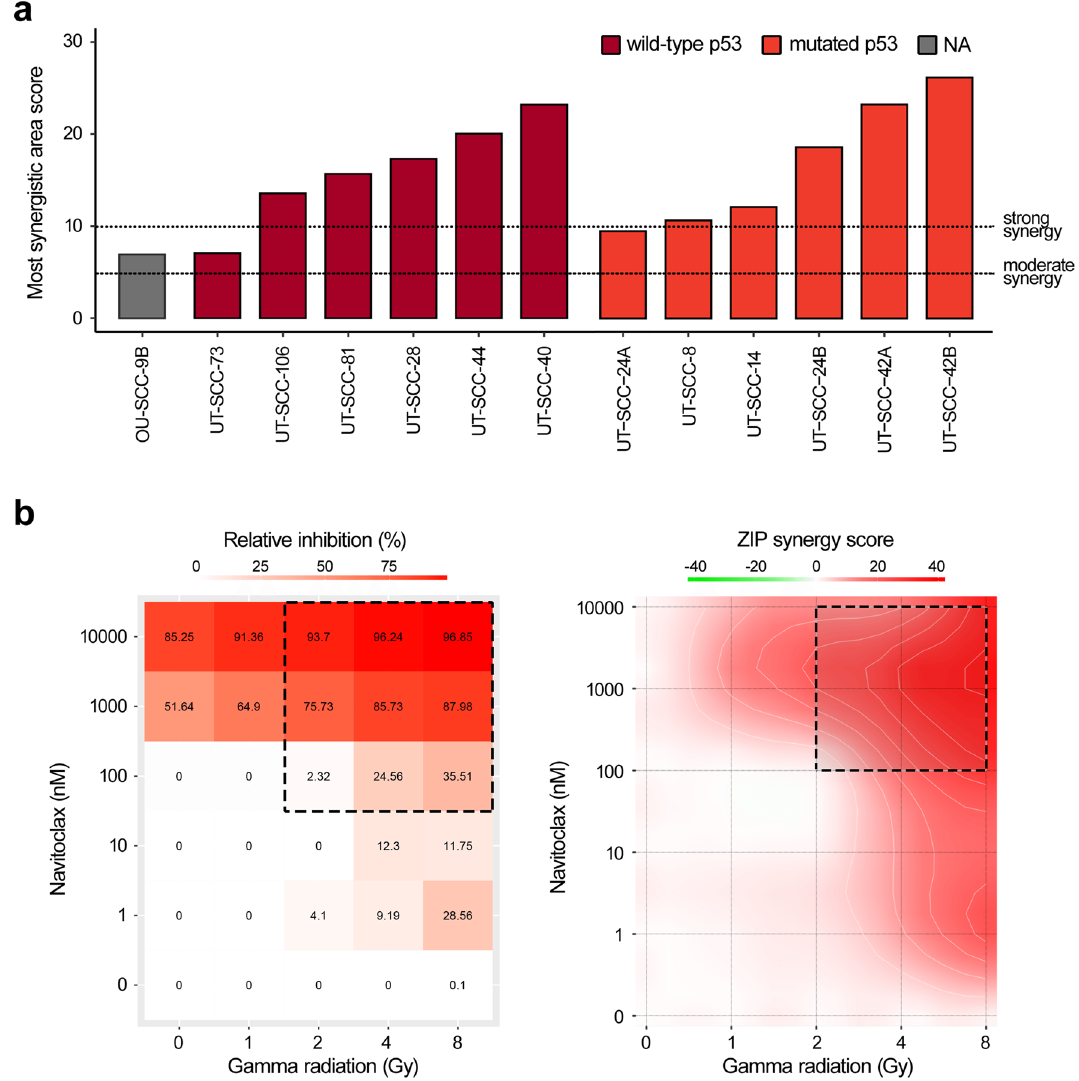
Figure 3. The combination of navitoclax and irradiation exhibited a strong synergy regardless of the p53 mutation status. (a) The most synergistic area scores for the navitoclax–irradiation combination across 13 HNSCC cell lines. (b) A representative example of the navitoclax–irradiation combination tested on the UT-SCC-40 cell line. The dose–response matrix showing CTG viability for different dose pairs (left) and the synergy distribution plot calculated based on the ZIP synergy reference model (right) are shown. The most synergistic area score represents a synergy score calculated for the most synergistic 3 × 3 dose window (dashed